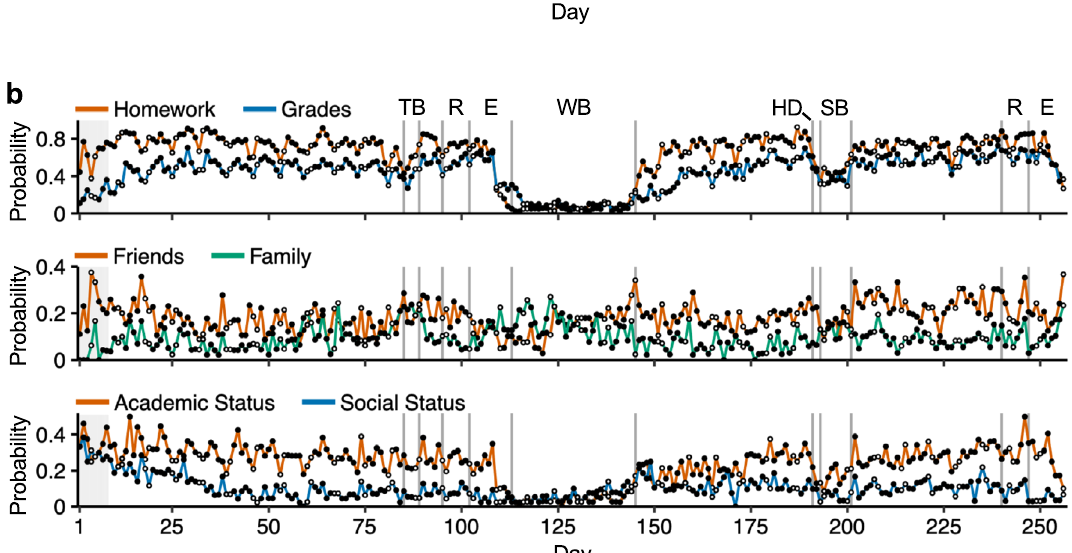
Figure 2. School-related fluctuations extended to various behavioral and affective domains. ( a ) Time series show survey-derived daily observations averaged across the full sample. Vertical lines indicate landmark events in the academic calendar, labeled at the top. Black circles indicate Monday through Friday and white circles indicate Saturday and Sunday. The top panel shows the probability that survey-based observation is missing on any given day (i.e., the proportion of missing individual observations out of the total sample), and the gray shading across panels indicates days with more than 50% missing observations. ( b ) Some of the individual stressor items that made up the composite academic, social, and status stress categories (displayed in the last panel of ( a )) are shown in the first, second, and third panels, respectively. TB thanksgiving break, R reading period, E exams period, WB winter break, HD housing day, SB spring break, H-Y Harvard-Yale football game, Festival music festival hosted on